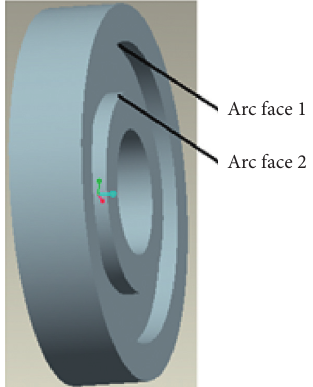
Figure 3: The typical arc edge for weight removing.